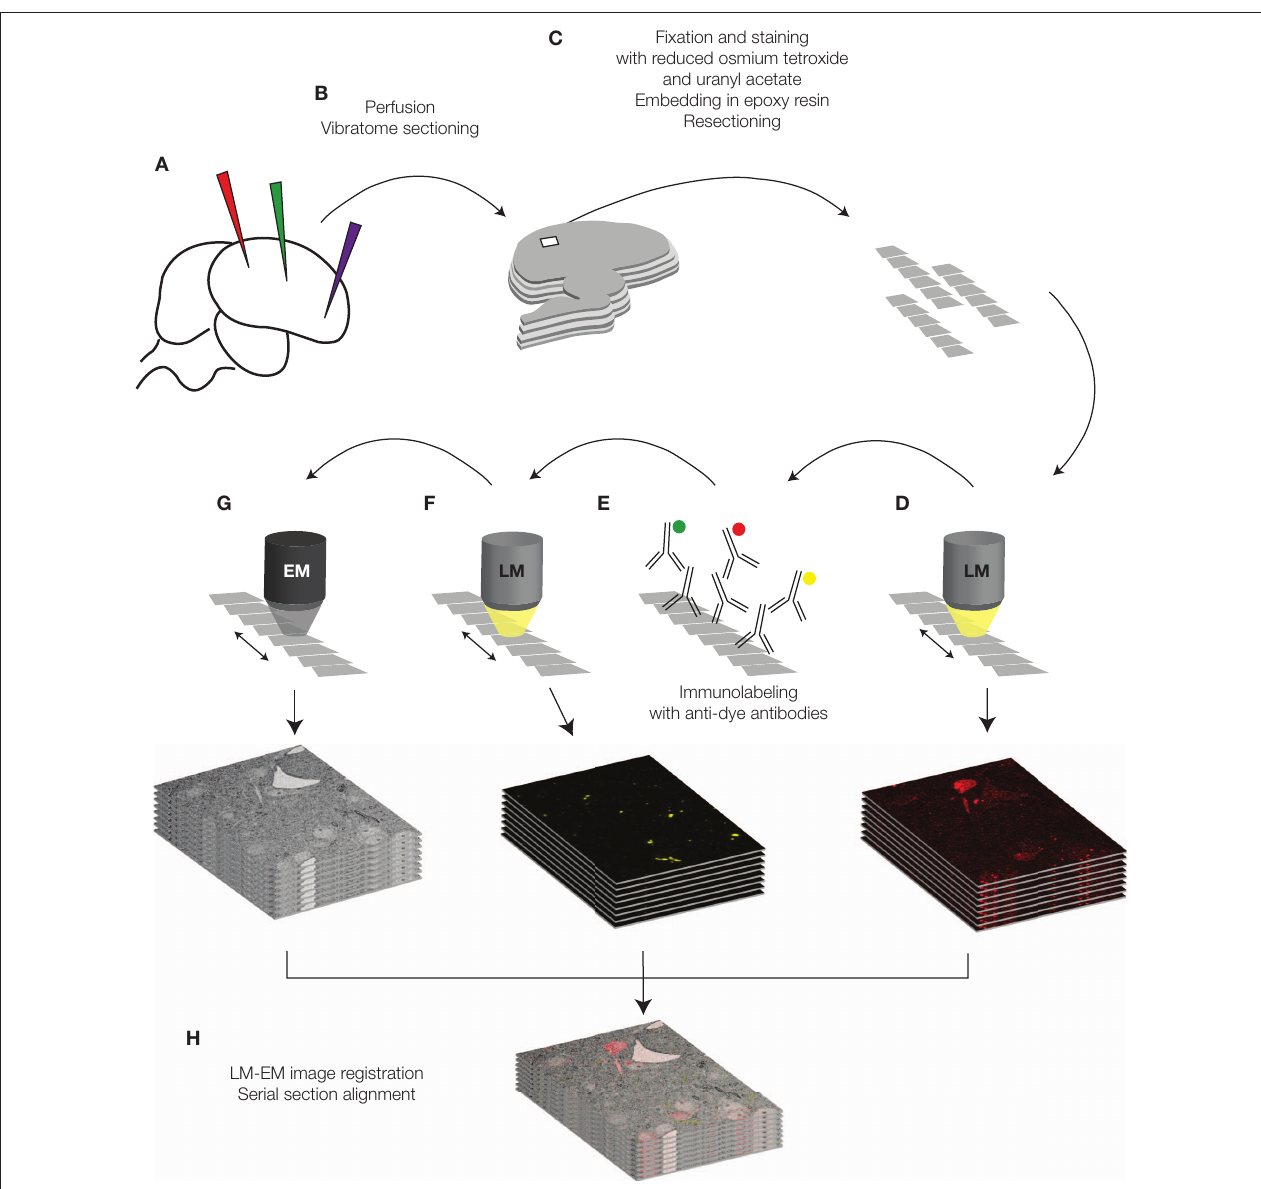
Figure 2 | Schematic drawing of the tissue preparation and imaging process. The different steps are described in detail in the